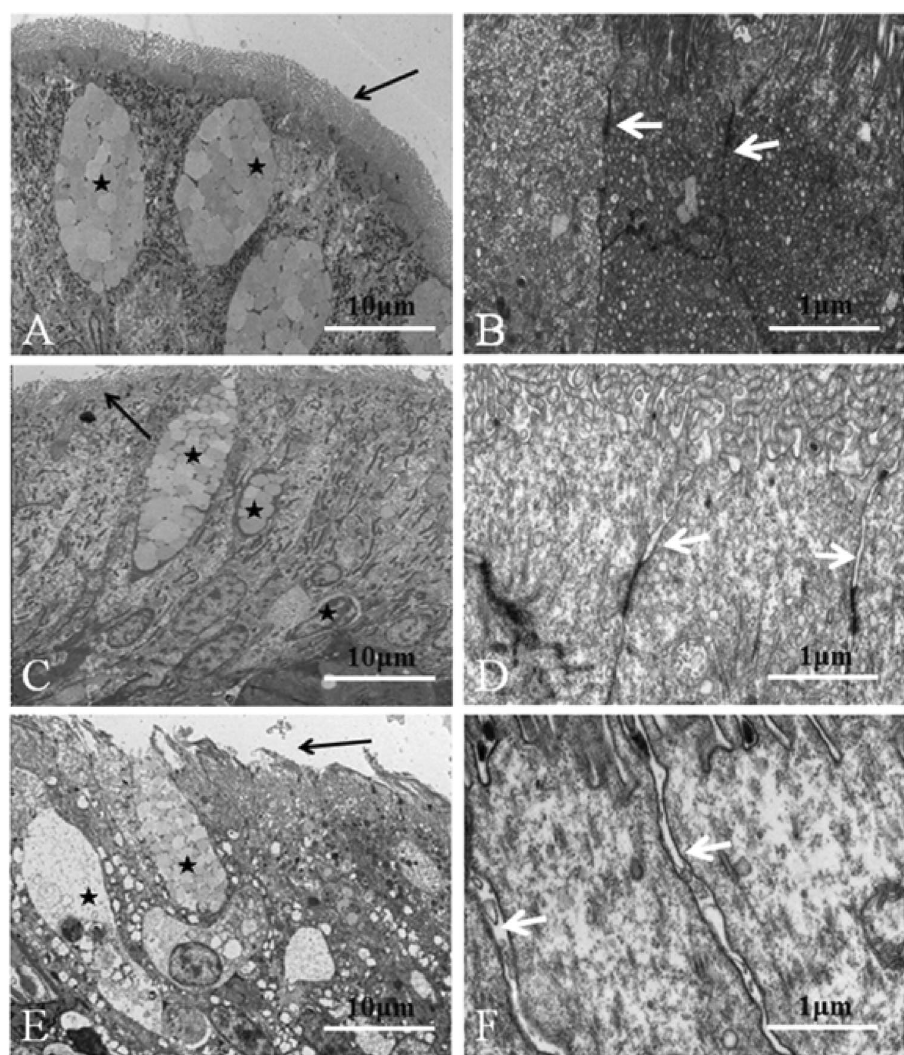
Figure 2. Electron microscopic structures of epithelial cells in the DI tissues of grouper. Note: ( A ), ( B )- FM control group, ( C , D )-SBM20 group, ( E , F )-SBM40 group. Asterisks represent goblet cells. Black arrows represent the microvilli of intestinal epithelial cells. White arrows represent intercellular junctions between the epithelium